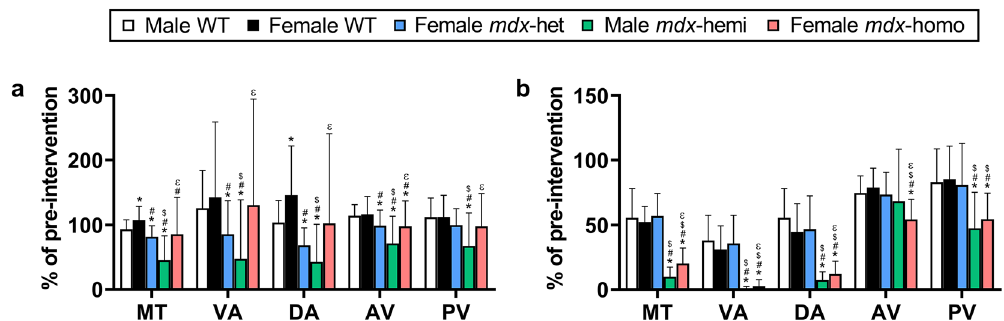
Figure 1. Partial dystrophin expression desensitizes mdx mice to behavioural stress. ( a ) Physical activity in response to forced downhill treadmill exercise and ( b ) a 30 s scruff-restraint. Data are presented as the ratio of post-stressor physical activity to pre-stressor physical activity (% of intervention). WT wildtype, het heterozygous, hemi hemizygous, homo homozygous, MT movement time (s), VA vertical activity (counts), DA distance ambulated (m), AV average velocity (m/s), PV peak velocity (m/s). Male WT (n = 49), female WT (n = 42), mdx -het (n = 77), mdx -hemi (n = 119) and mdx -homo (n = 117). Data are mean ± SD. *Different from male WT, # different from female WT, $ different from female mdx -het, ε different from male mdx -hemi.